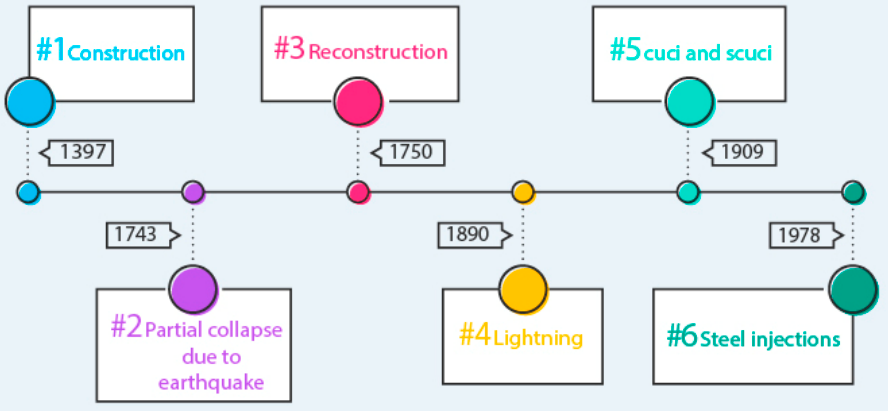
Figure 3. Timeline of the significant events modifying the architectural aspect and the structural behavior of the Soleto’s bell-tower.